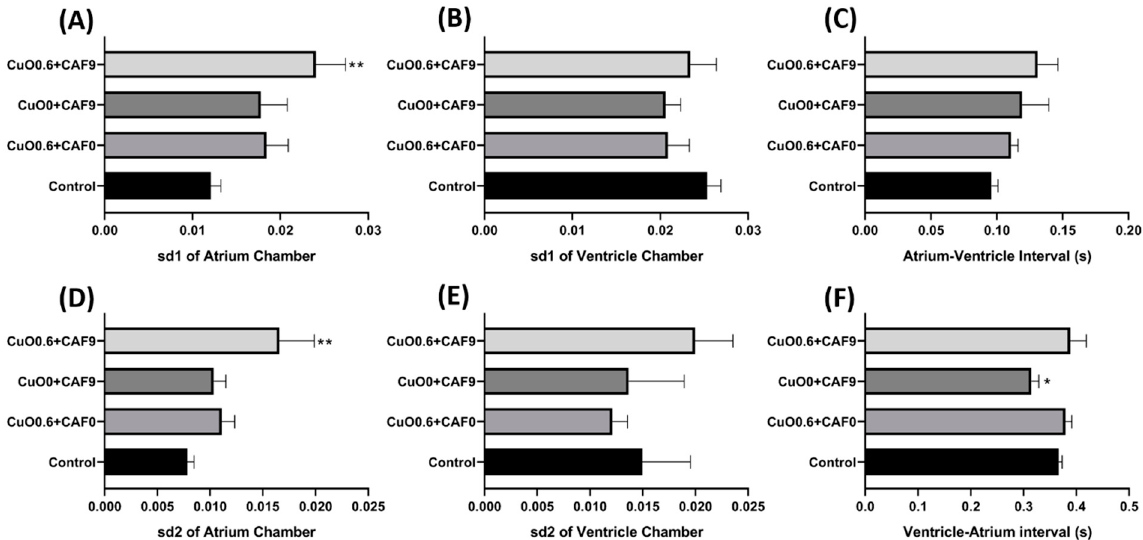
Figure 8. Cardiac rhythm alteration induced by CuO nanoparticle and carbofuran co-incubation in zebrafish larvae. ( A ) Atrium SD1. ( B ) Ventricle SD1. ( C ) Atrium–ventricle interval. ( D ) Atrium SD2. ( E ) Ventricle SD2. ( F ) Ventricle–atrium interval. Data were statistically analyzed using the Kruskal–Wallis ANOVA test with Dunn’s post-hoc test for multiple comparison * p < 0.05, * * p < 0.005. (CuO = copper nanoparticle (mM), CAF = carbofuran (µM)).